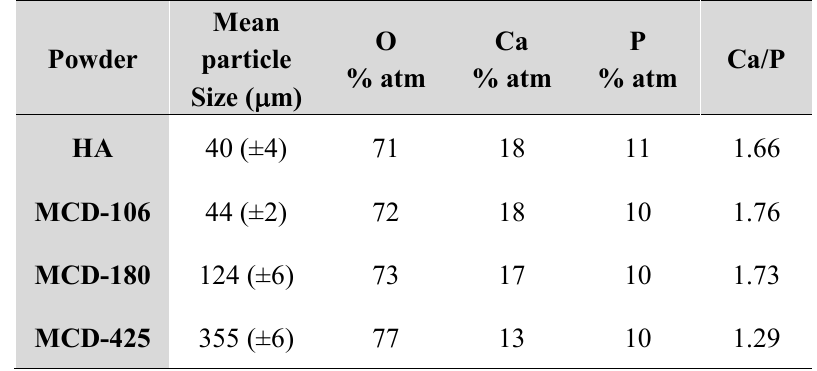
Table 1. Mean particle size analysis and energy dispersive X-ray (EDX) analysis of the calcium phosphate powders (n =